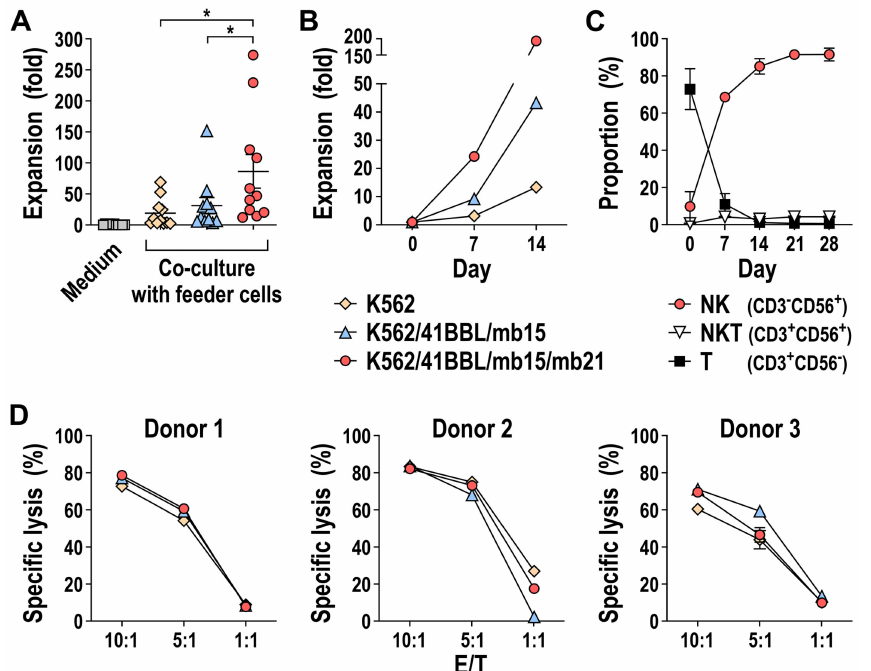
Figure 5. Selective expansion of CD56 + NK cells from peripheral blood with K562 / 41BBL / mb15 /